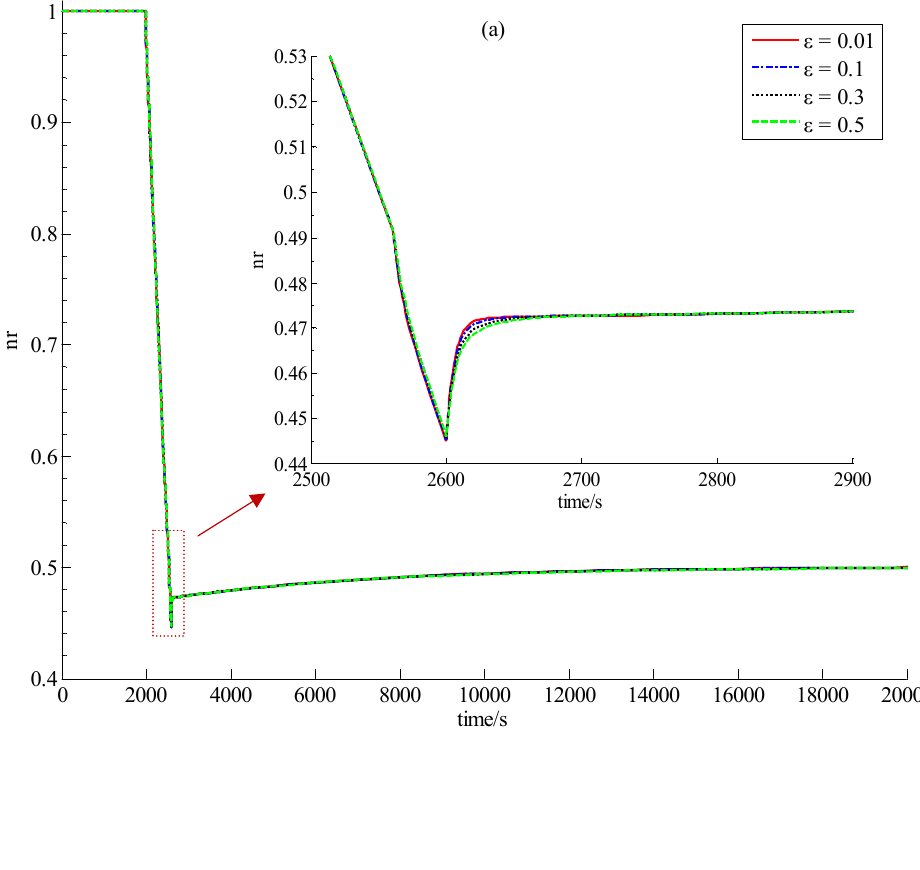
Figure 4. Dynamic responses in Case A of ( a ) relative nuclear power; ( b ) average fuel temperature; ( c ) outlet helium temperature and ( d ) control rod speed signal with constant σ and different ε